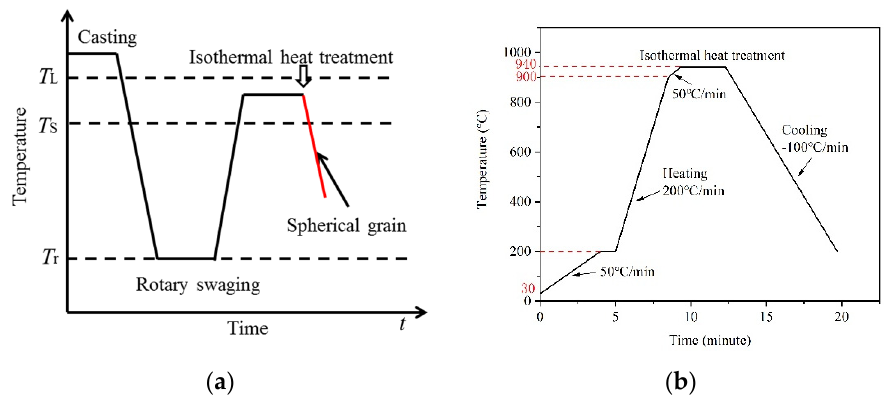
Figure 1. ( a ) Schematic diagram of the rotary swaging strain-induced melt activation (RSSIMA) process ( T L : liquidus, T S : solidus, and T r : room temperature) and ( b ) actual heating cycle during high-temperature confocal laser scanning microscopy (HT − C LSM).